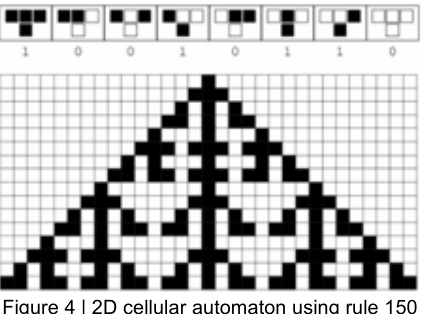
Figure 4 | 2D cellular automaton using rule